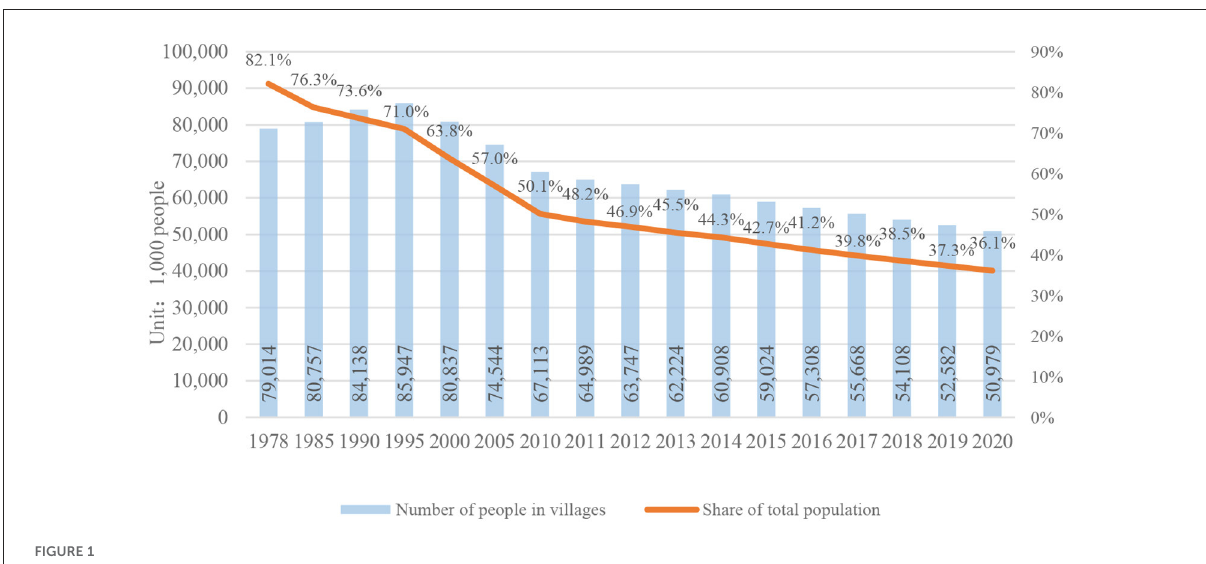
FIGURE1 Number and proportion of the country’s population living in rural